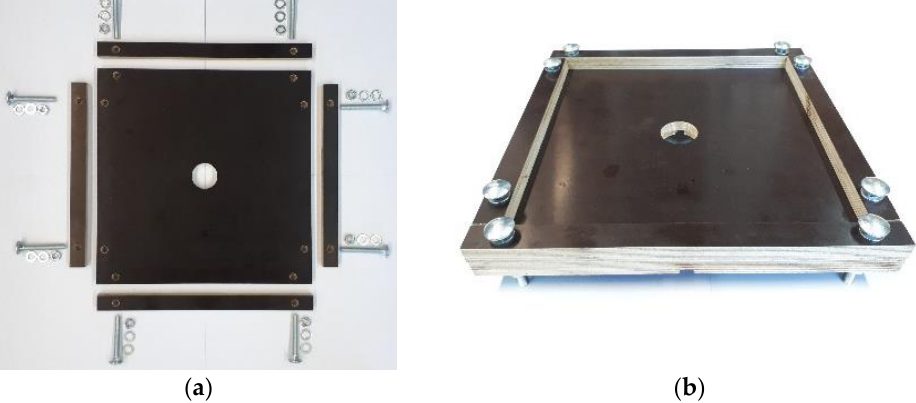
Figure 1. Mould used in the manufacture of SP: ( a ) mould components; ( b ) mould